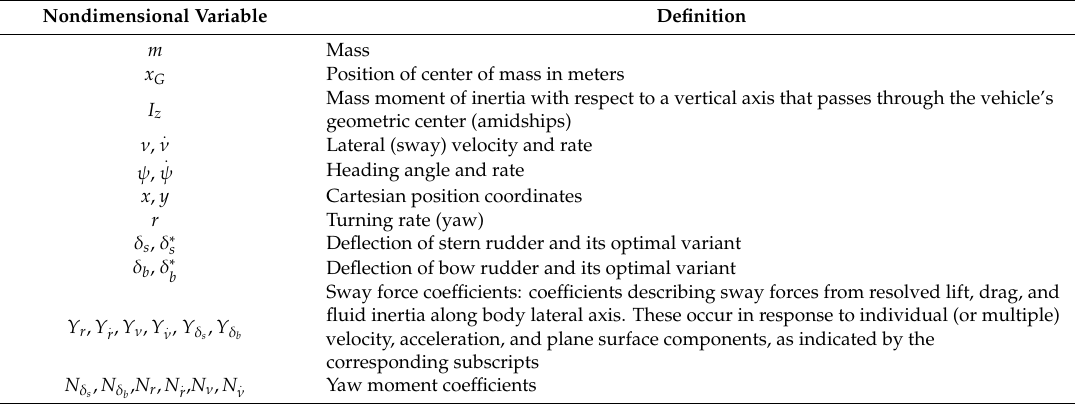
Table A1. Consolidated table of variable